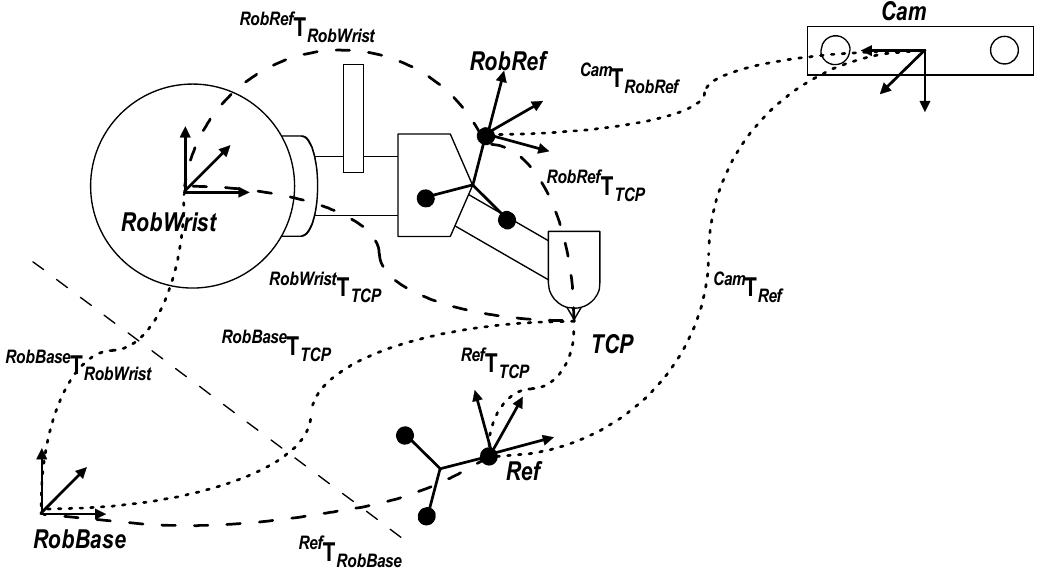
Figure 12. To obtain the rigid transformation RobRef T measured using a pivot calibration following by a pair-point method with an additional DRF ( Ref